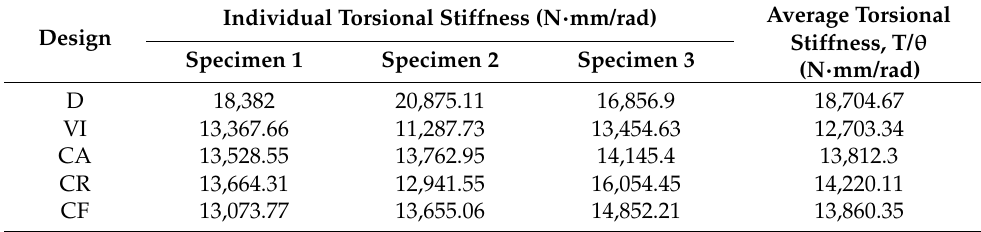
Table 3. Individual and average torsional stiffness values of